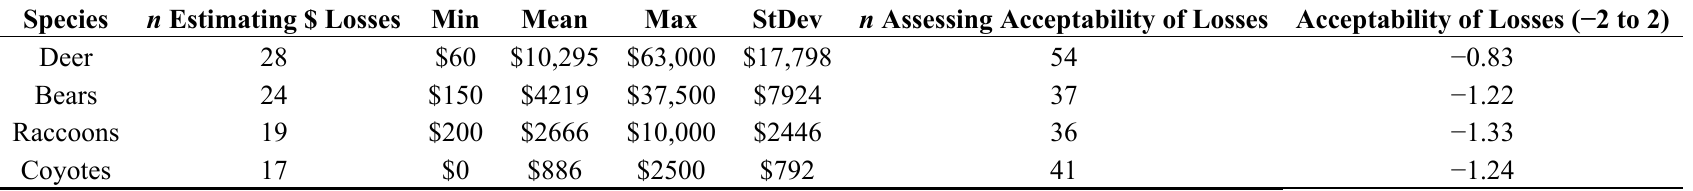
Table 3. Estimated financial losses for the top four species, based on survey responses.